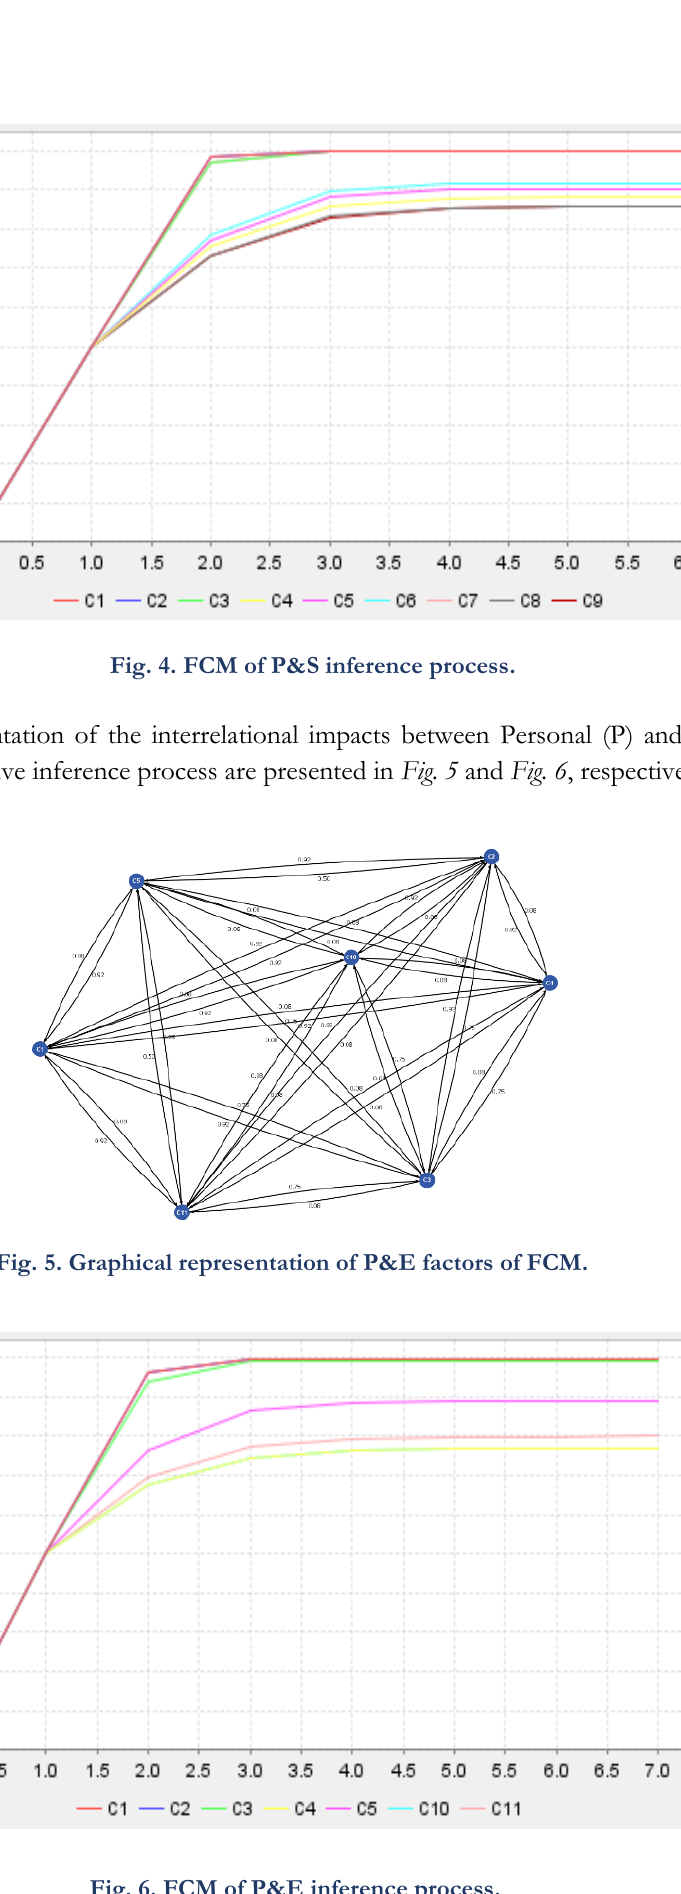
Fig. 6. FCM of P&E inference